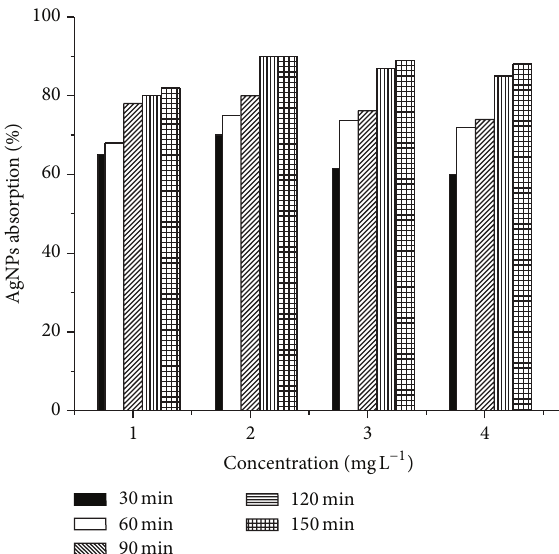
Figure 3: Efficiency adsorption plot of AgNPs on the